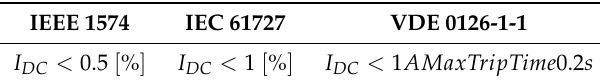
Table A8. DC current